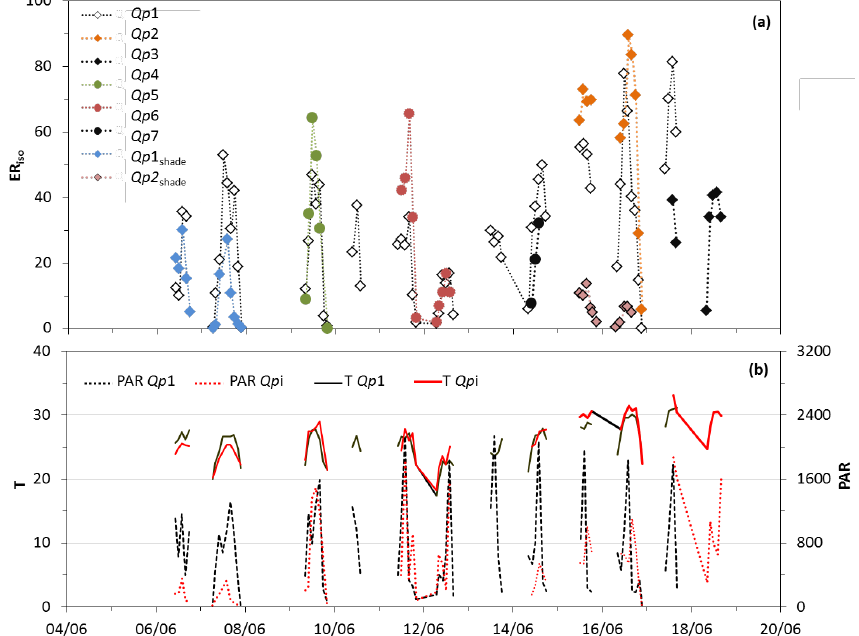
h − 1 ) measured from all i Qp i branches sampled on the O 3 HP DM